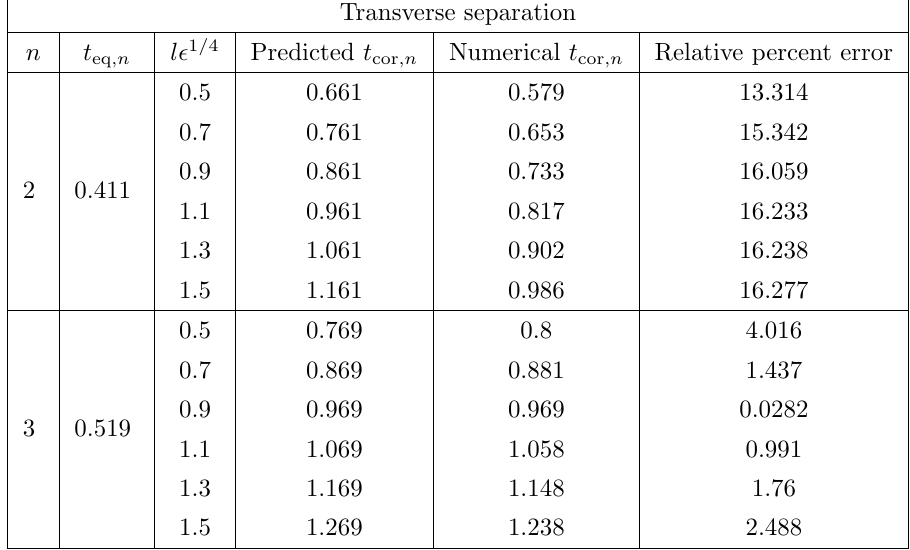
understanding of why it is instructive to study the times t in the backgrounds evolution. eq ;n The diagram shows the horizontal (cid:12)eld theory time axis labeled t , while the vertical axis labeled x represents a spatial coordinate in the (cid:12)eld theory ( x; y , or x 3 ). 10 Consider the dotted line labeled t as a time at which the background 1-point functions pass eq ;n